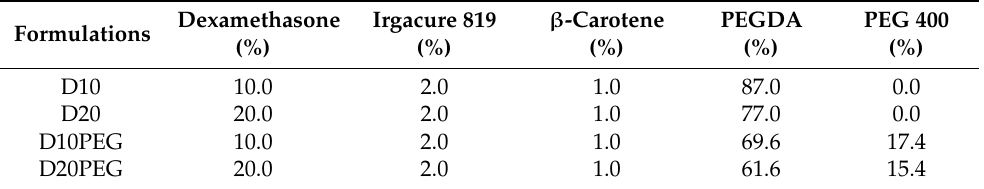
Table 1. Compositions (% w / w ) of the drug-loaded photopolymer resins.